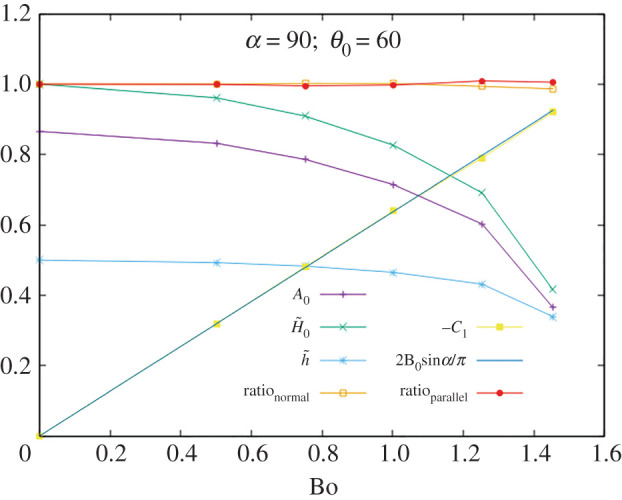
Testing the identities for α = 90° and θ0 = 60°.